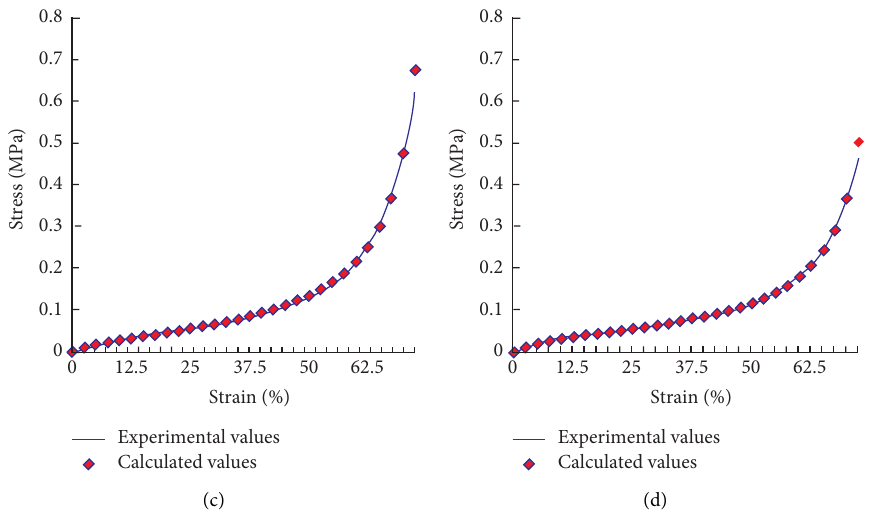
Figure 6: Comparison of the stress-strain curves of the different samples of the experimental values and calculated value.